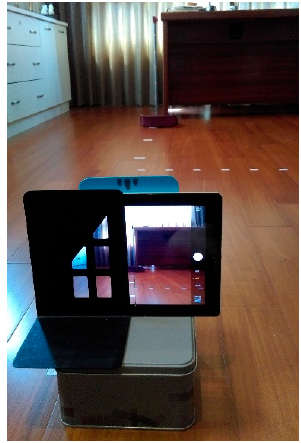
Figure 8. Measurement verification by tablet.